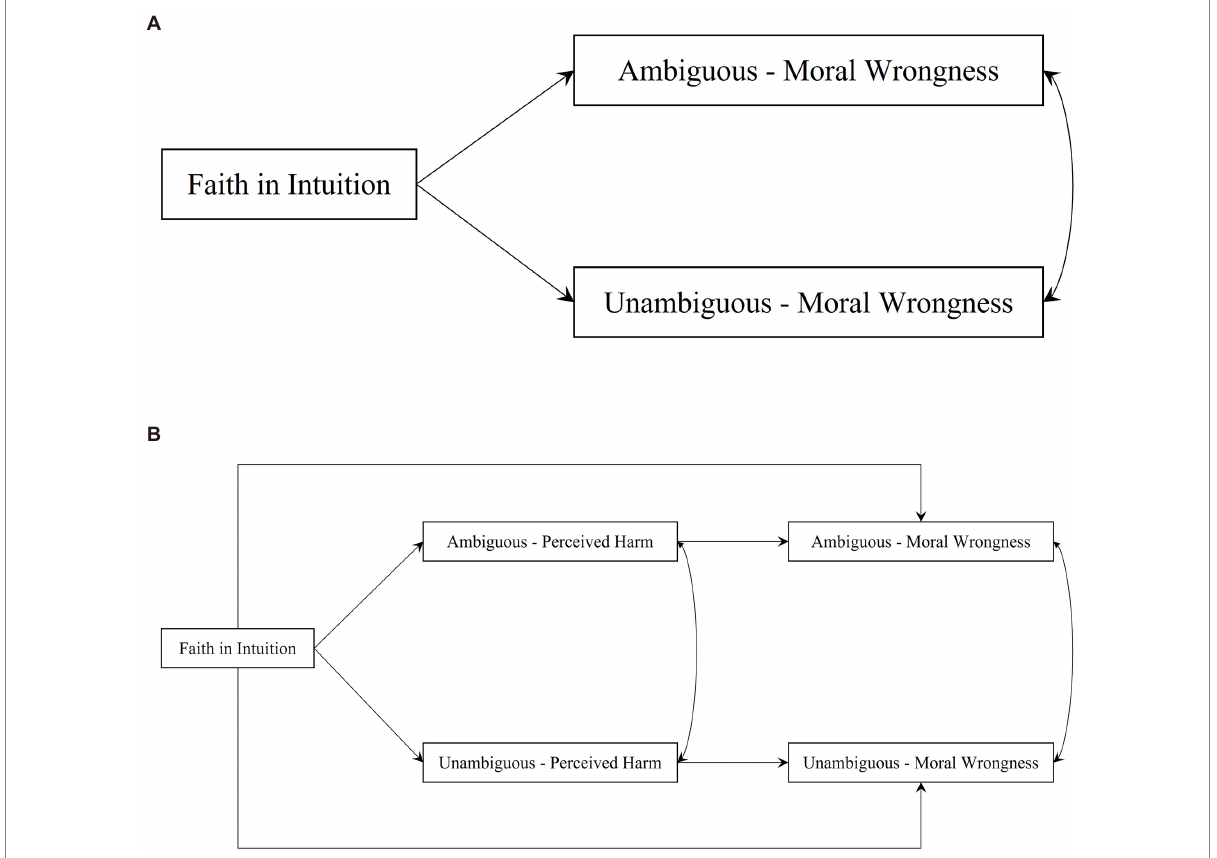
FIGURE 1 Theoretical model diagram. (A) Theoretical model diagram of Hypotheses 1a and 1b. (B) Theoretical model diagram of Hypotheses 2a and